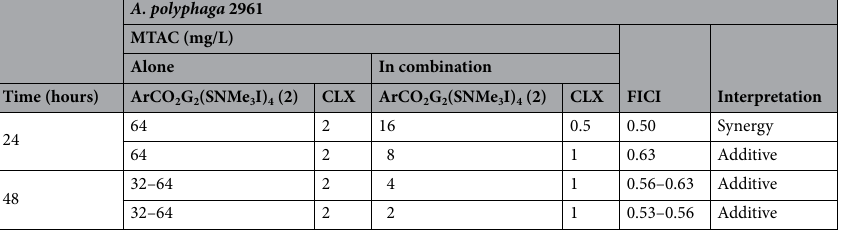
Table 5. Fractional inhibitory concentration index (FICI) in A. polyphaga 2961 trophozoites and interpretation of the effect MTAC (mg/L) for ArCO 2 G 2 (SNMe 3 I) 4 ( 2 ) and CLX alone or in combination after 24 and 48 h of treatment.